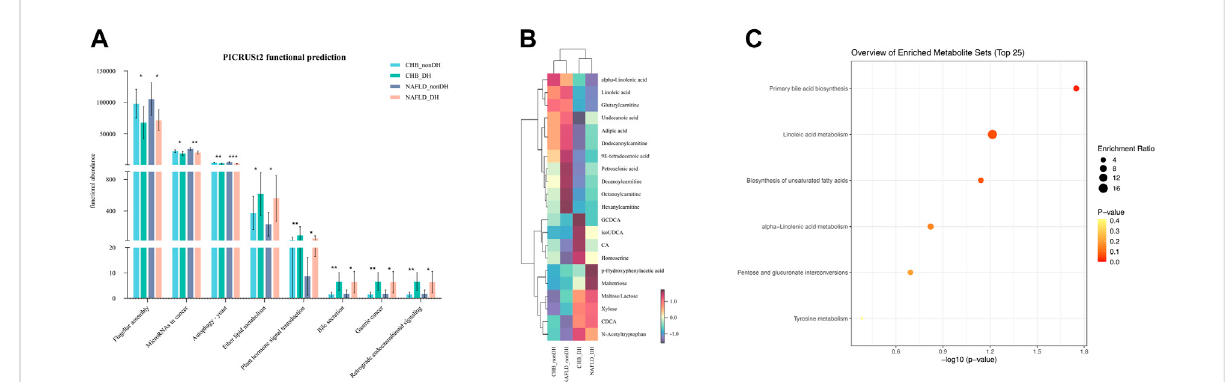
FIGURE 3 Patients with DH syndrome are associated with aberrant BA metabolism. (A) Functional pathways with the same trend predicted based on 870OTUs, * p < 0.05,** p < 0.01,*** p < 0.001; (B) heatmapof21metabolites withthesameexpressiontrendsinDHsyndromegroups; (C) functional enrichment analysis based on the 21